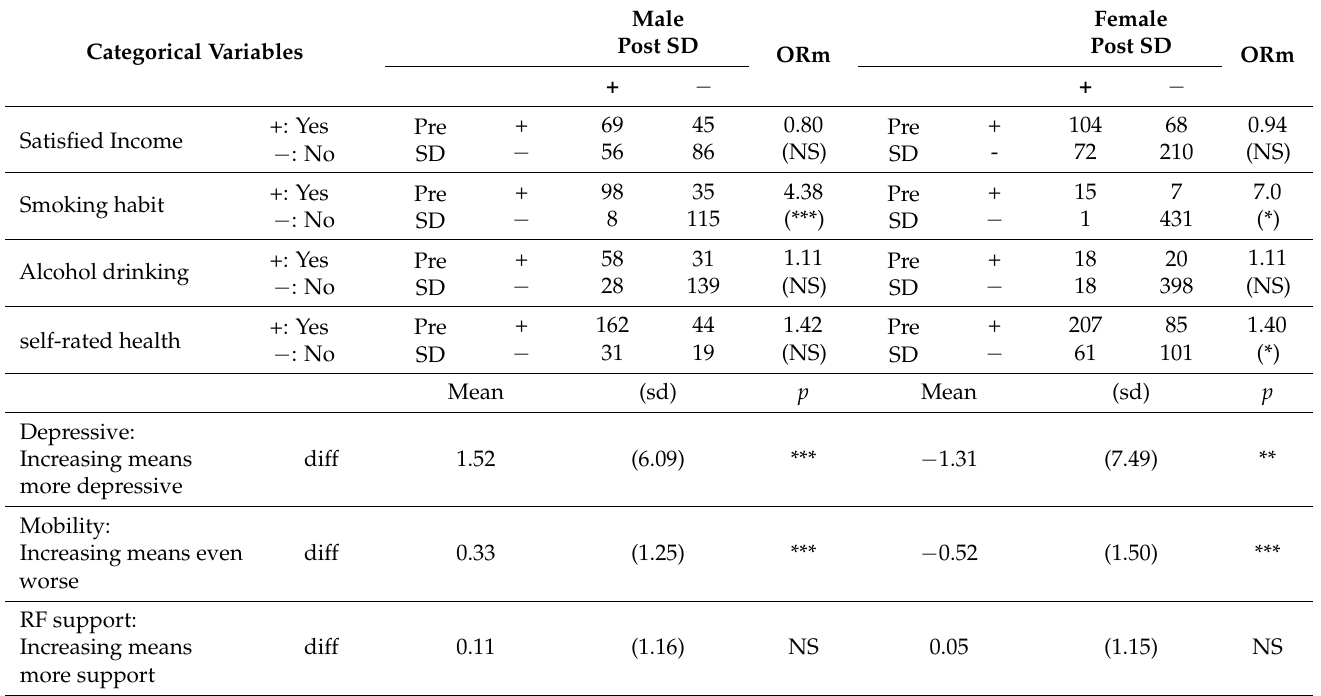
Table 4. Characteristics of study subjects: pre and post spouse death